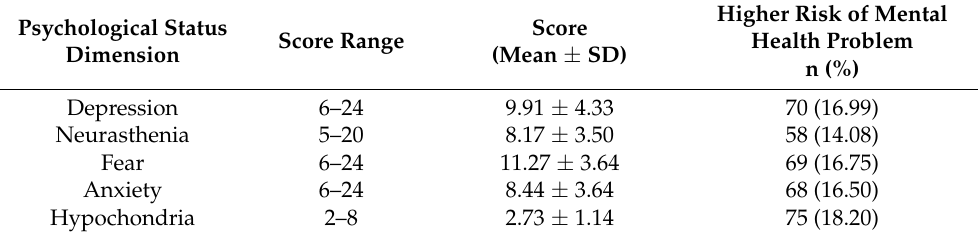
Table 3. Psychological status of the MSM population (n =